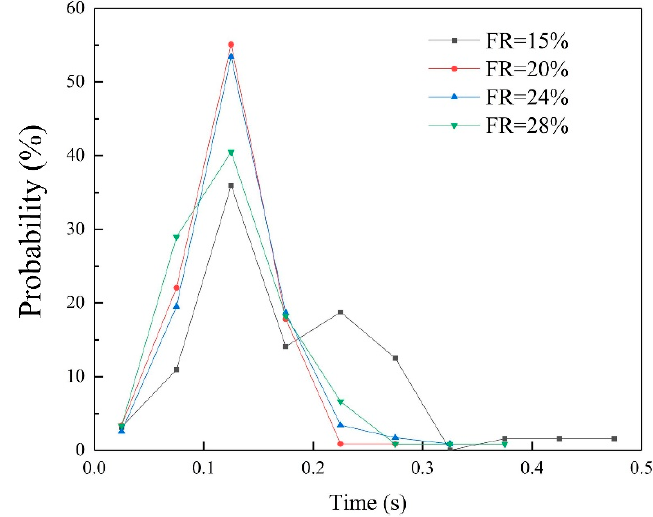
Figure 9. The effect of filling rate on probability of droplet growth time.